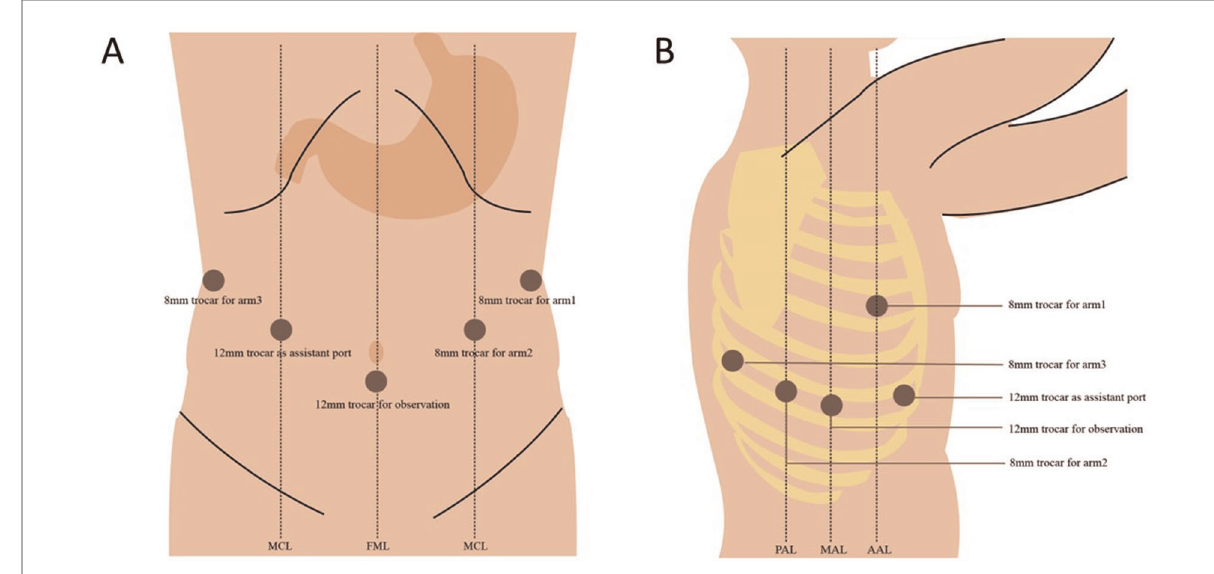
FIGURE 1 An example of patient positioning and trocar placement in our hospital. ( A ) Abdominal phase and ( B ) thoracic phase.